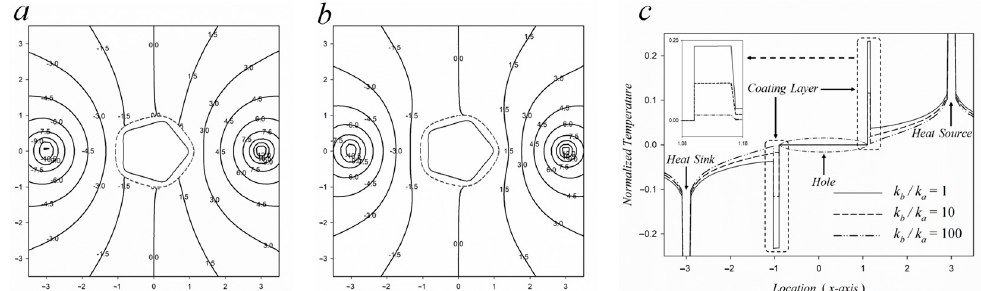
Figure 7. Contours of temperature distribution for a coated equiangular pentagonal hole, where ( a ) k b /k a = 10 and ( b ) k b /k a = 100. ( c ) Quantitatively normalized temperature for a coated triangular hole with different ratios of heat conductivity, where w = 0.1.